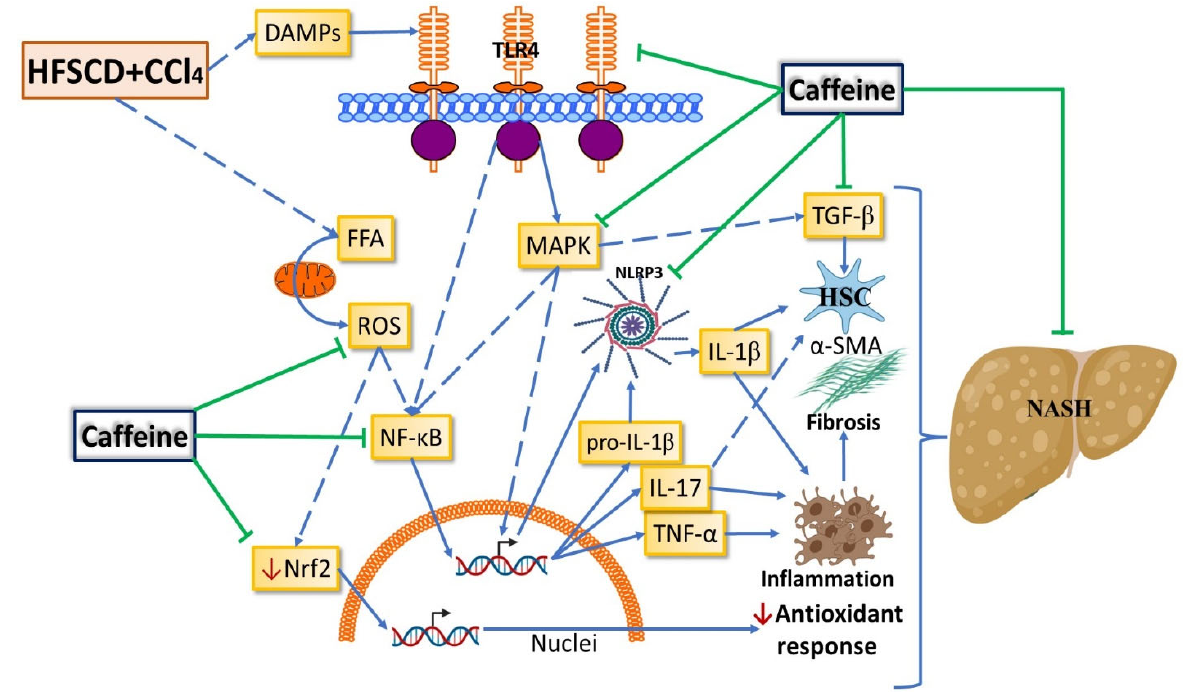
Figure 9. Schematic diagram showing how caffeine affects the NASH experimental model. Caffeine attenuates the experimental NASH progression possibly by modulating the nuclear factor erythroid 2- related factor 2 (Nrf2) and nuclear factor- κ B (NF- κ B) signaling pathways, thereby reducing oxidative stress and inflammation, respectively. Caffeine also attenuates fibrosis progression by modulating mitogen-activated protein kinases (MAPK) and transforming growth factor-beta (TGF- β ) signaling pathways, thereby decreasing the activation of hepatic stellate cells (HSCs). Caffeine inhibits inflammasome activation by blocking the toll-like receptor 4 (TLR4)/MAPK/NF- κ B signaling pathway. ROS: reactive oxygen species; DAMPs: damage-associated molecular patterns; α -SMA: smooth muscle alpha ‐ actin; IL: interleukin; TNF ‐α : tumor necrosis factor ‐ alpha.